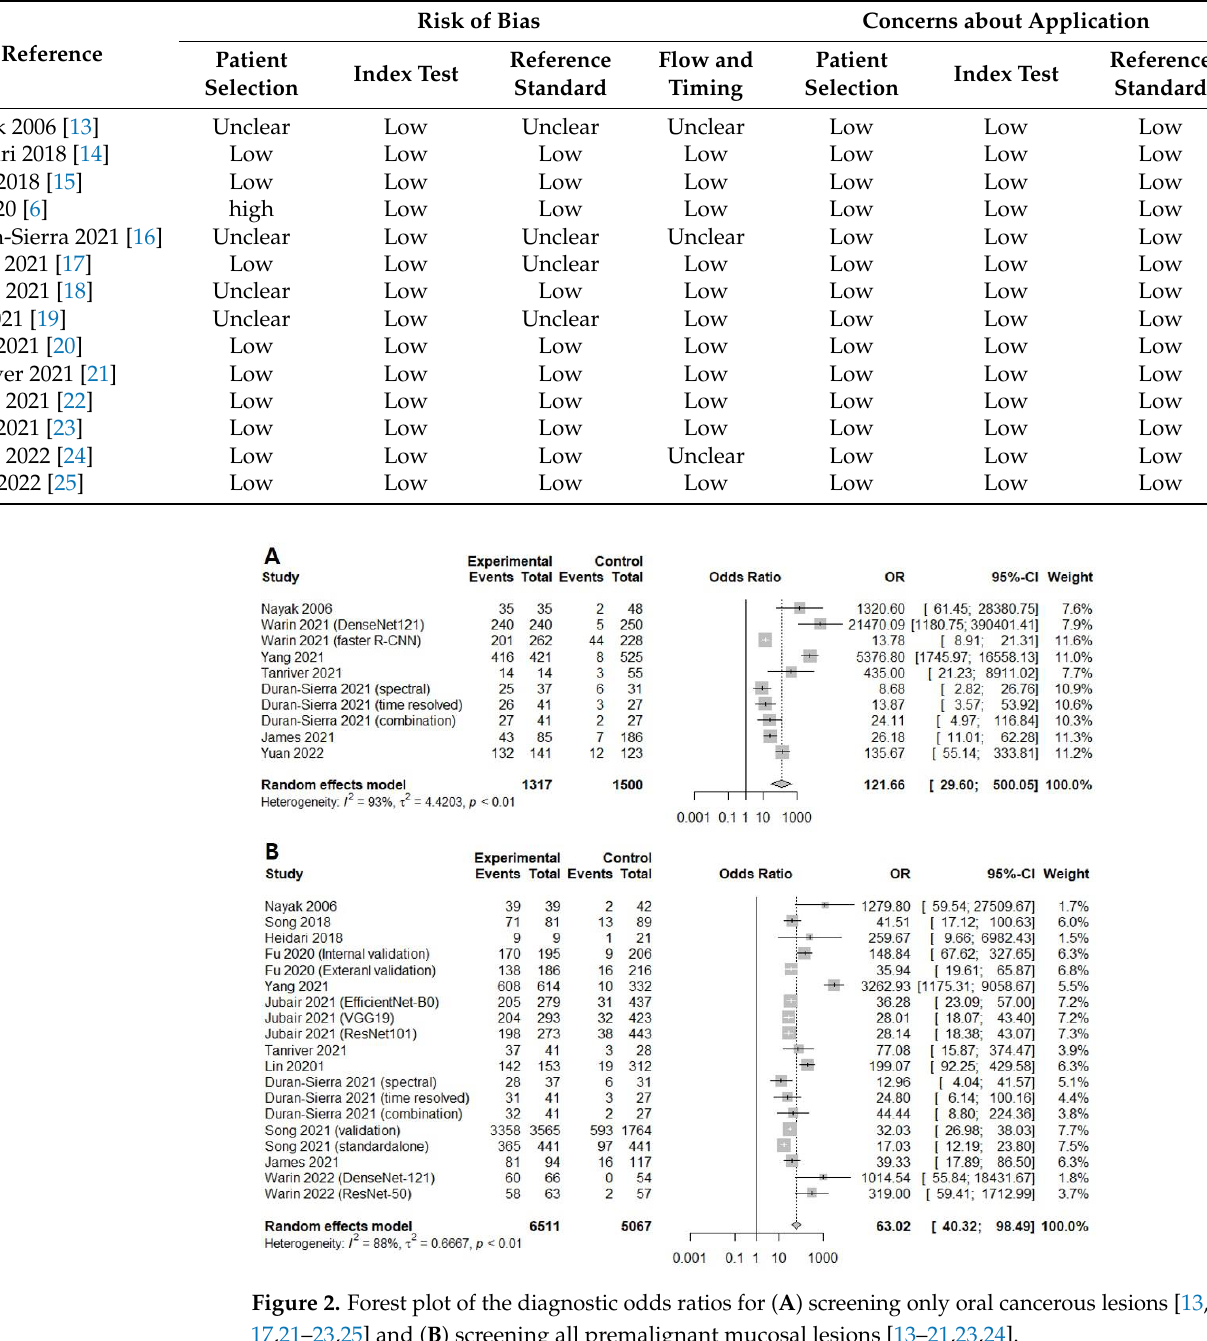
Table 1. Methodological quality of all included studies.